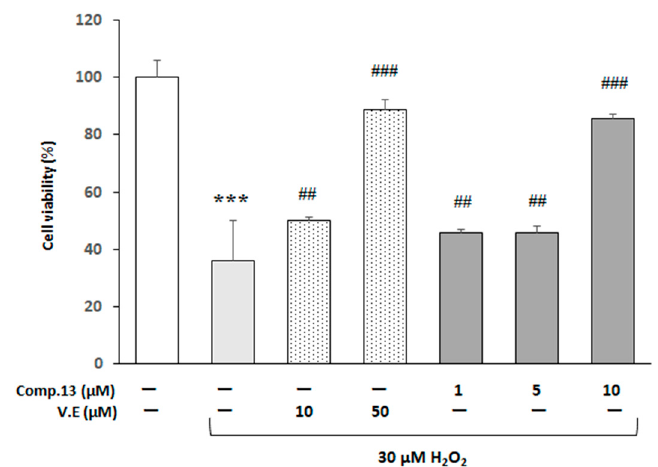
Figure 4. Effects of compound 13 and vitamin E on neuro2a cell viability. Neuro2a cells pretreated with test compounds (compound 13 at the concentration of 1–10 µ M or vitamin E at the concentration of 10–50 µ M) were exposed to 30 µ M H 2 O 2 . The results represent the mean ± SEM ( n = 5, different culture). Symbols are significantly different for the following condition; vs. none-treated cells (*** p <